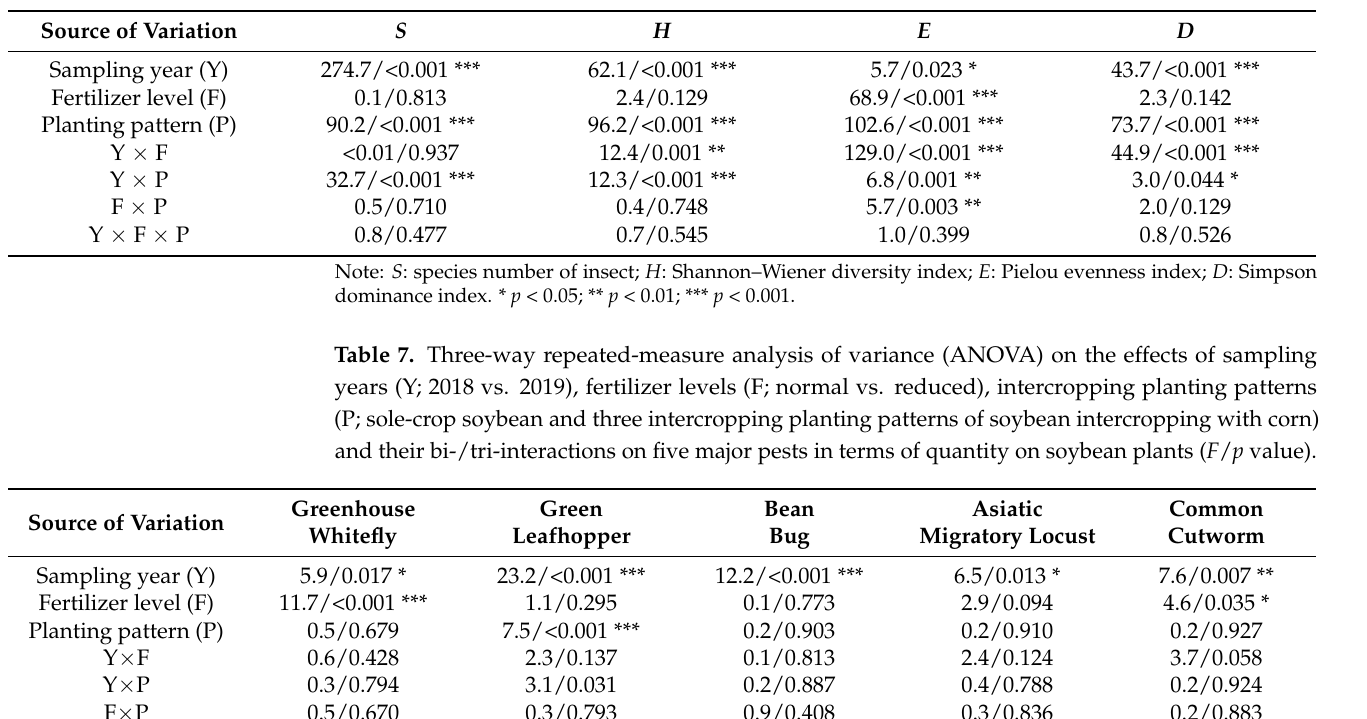
Table 6. Three-way repeated-measure analysis of variance (ANOVA) of the effects of sampling years (Y; 2018 vs. 2019), fertilizer levels (F; normal vs. reduced), intercropping planting patterns (P; sole-crop soybean and three intercropping planting patterns of soybean with corn) and their bi-/tri-interactions on community diversity indices of insects ( F / p value).